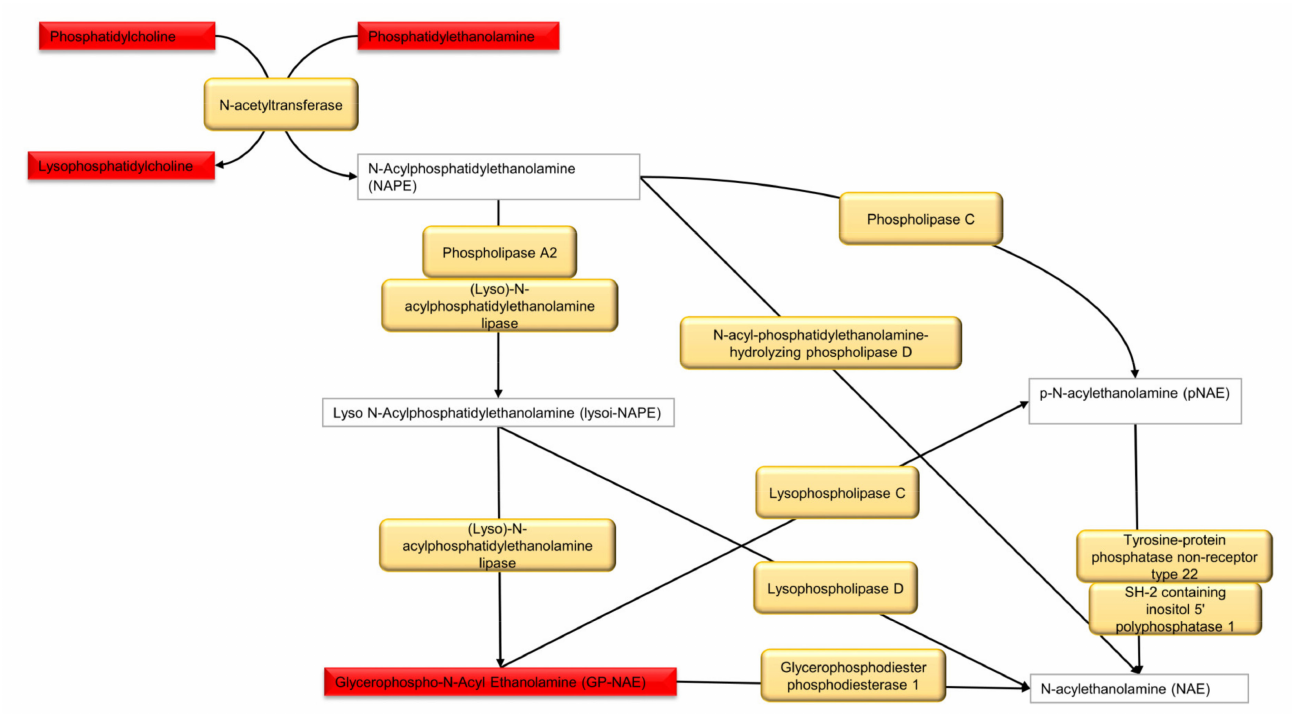
Figure 4. Pathway of glycerophospholipid metabolism. The metabolites in the red rectangle have a decreased percent of change in SCC vs. ADC comparison.